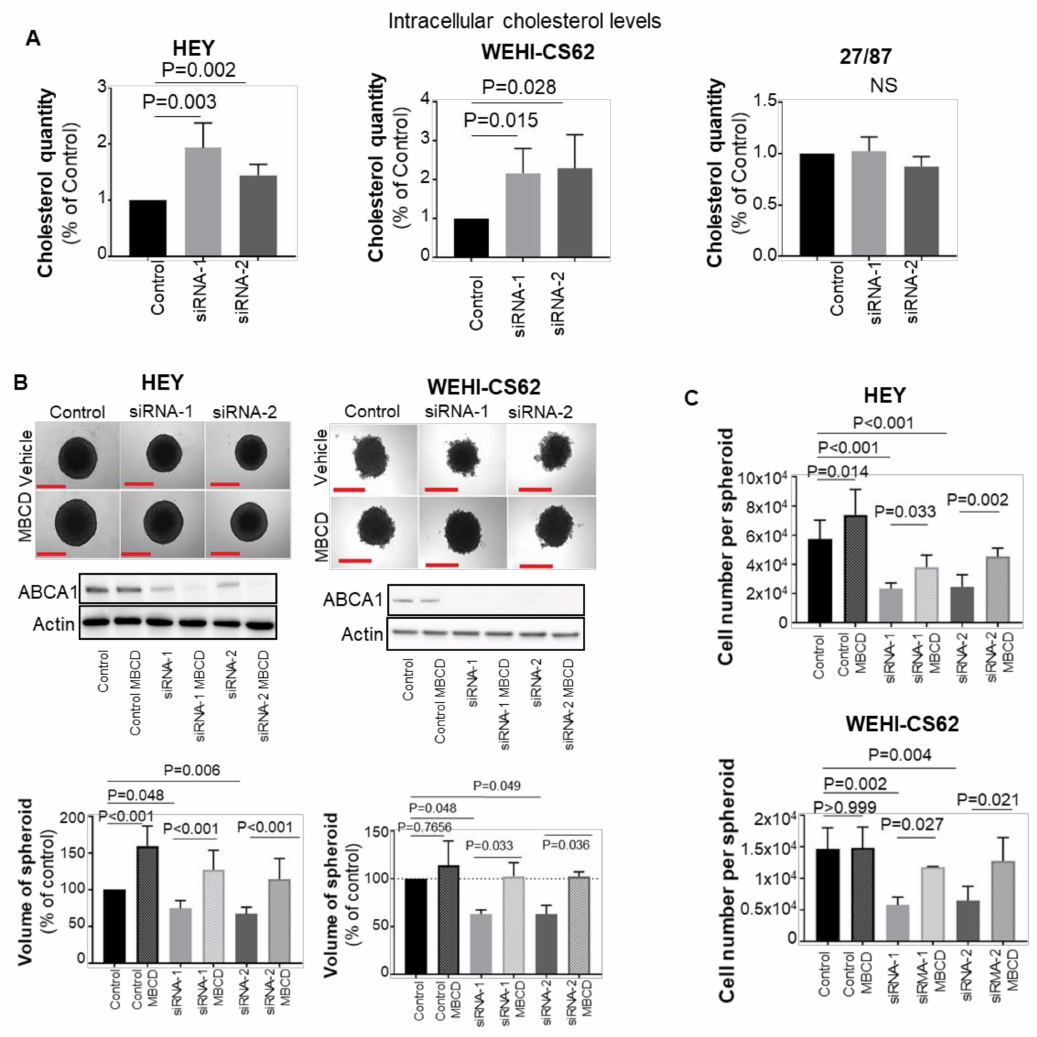
Figure 5. ABCA1 suppression induced cholesterol accumulation in serous ovarian cancer cells which was associated with decreased growth in the EOC cells. ( A ) Changes in intracellular cholesterol levels following ABCA1 suppression. n = 5 for serous HEY and WEHI-CS62 cells. n = 3 for endometrioid 27/87 cells. ( B ) Cholesterol depletion using methyl-B-cyclodextrin (MBCD) reversed the effect of ABCA1 suppression on 3D growth characteristics of HEY (upper panels) and WEHI-CS62 (lower panels). Experiments were performed at 144 h in 3D culture or 168 h after transfection for HEY and 72 h in 3D culture or 96 h after transfection for WEHI-CS62. n = 5 for HEY and n = 3 for WEHI-CS62 cells. ( C ) Changes in the number of cells per spheroid after ABCA1 suppression with or without MBCD treatment performed at same time points as for ( B ). n = 5 for HEY and n = 3 for WEHI-CS62 cells. All results represent mean ± SD. p -Values for ( A ) were derived from one-sample t -test, whilst all other p -values were derived from two-way ANOVA with Tukey’s multiple comparison tests. Scale bars represent 500 µ